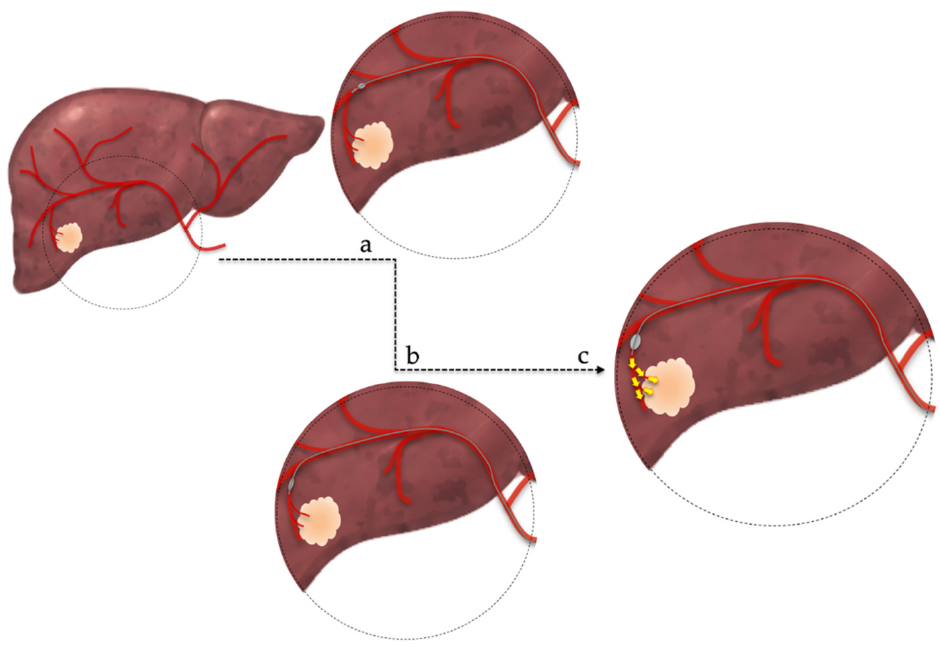
Figure 1. Balloon-occluded transarterial chemoembolization technique. ( a , b ): superselective catheterization of the arterial branch feeding the tumor, ( c ): occlusion of feeding artery by infletion of a microballoon catheter and subsequent administration of chemotherapeutic regimen.